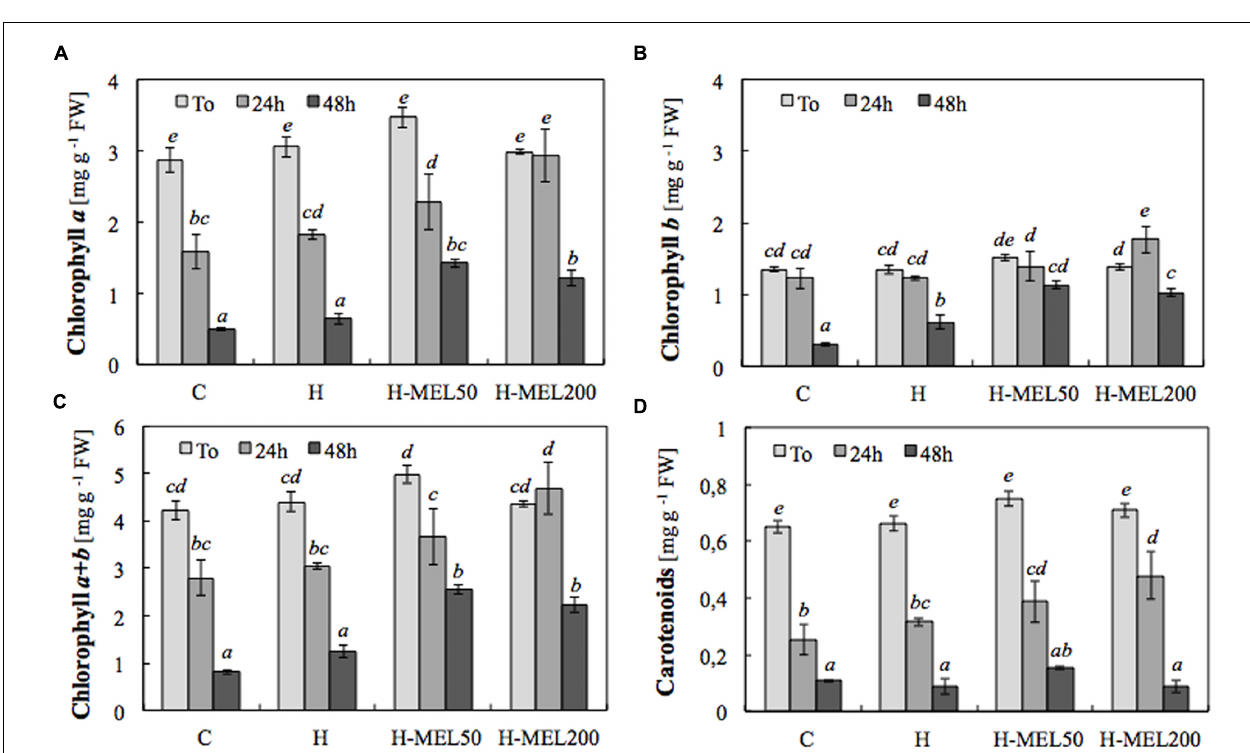
FIGURE 2 | Changes in green color intensity of leaf disks cut out of 24-day-old pea plants grown from the control (C), hydroprimed (H), and hydroprimed with an aqueous solution of 50 µ M melatonin (H-MEL50) or 200 µ M melatonin (H-MEL200) seeds. Photographs were taken after 48 h of disks incubation in 75 µ M PQ solution. The content of leaf pigments with statistical analysis at this time point (48 h) is presented in Figure 3 as dark gray bars.